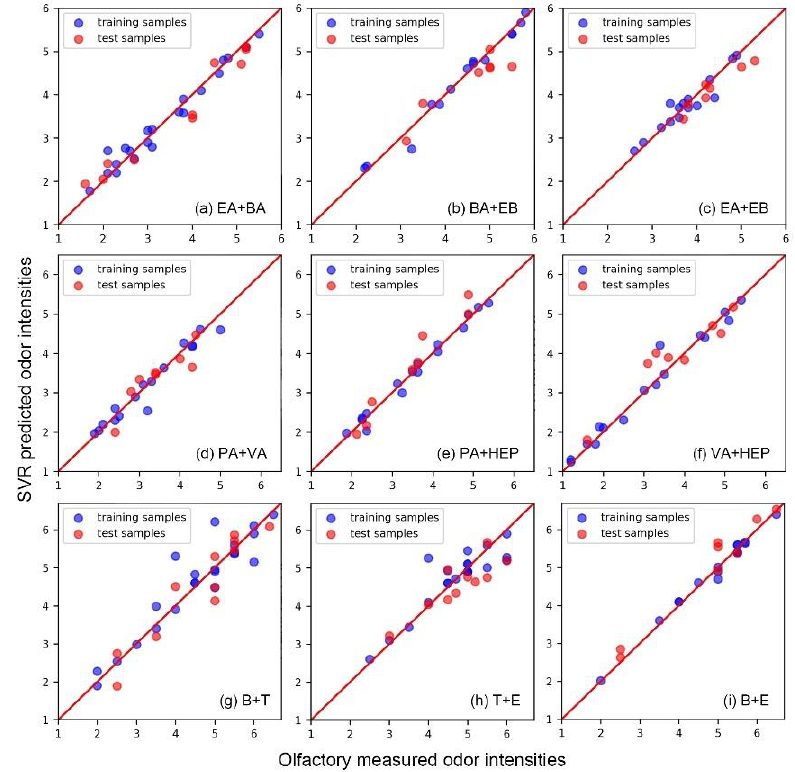
Figure 1. The comparison between olfactory measured odor intensity and Support Vector Regression (SVR) predicted the odor intensity of nine different binary mixtures. Table 2. The prediction accuracy of SVR models. The coefficient of determination ( R 2 ) and mean absolute error ( MAE ) were individually calculated for each kind of binary mixture.